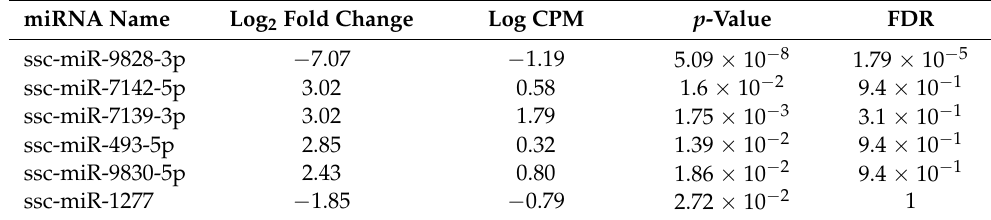
Table 2. List of differentially expressed miRNAs in direction of good semen quality